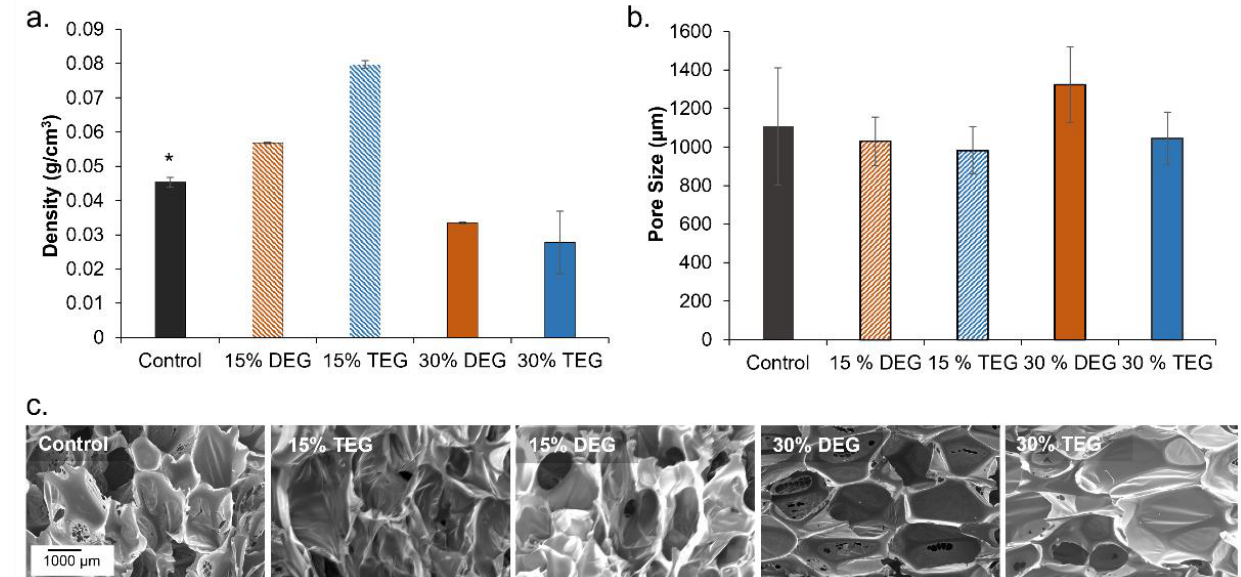
Figure 1. Structural properties of shape memory polymer foams. ( a ) The density of foams (n = 3), ( b ) average pore size of foams (n = 6) measured using SEM images on samples cut parallel and perpendicular to foam rise, and ( c ) representative micrographs of pore morphology. Scale bar of 1000 µm applies to all images. Mean ± standard deviation displayed in all panels. * p < 0.05 relative to all other foams.